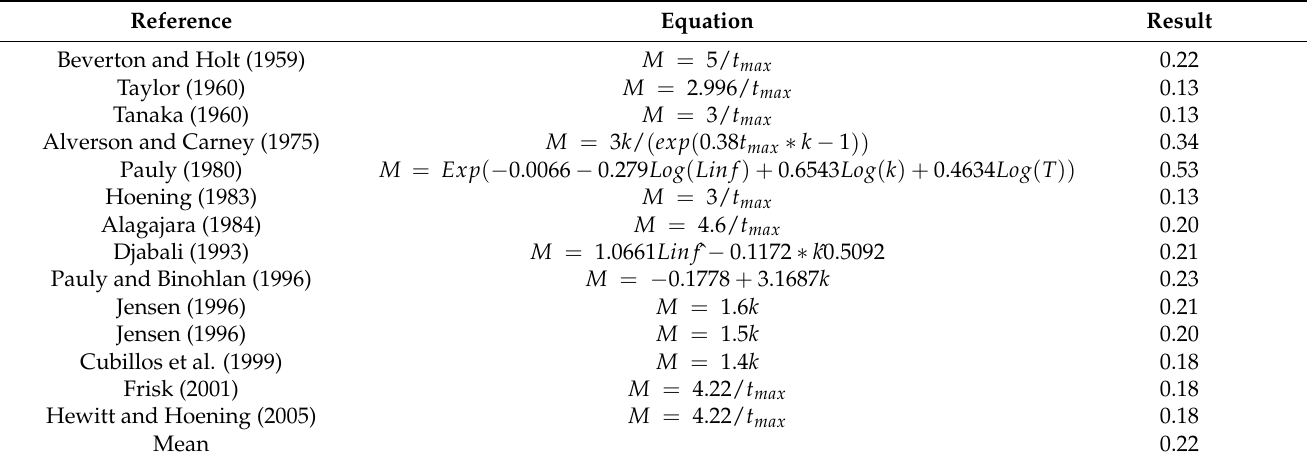
Table 2. Estimates of natural mortality ( M ; year − 1 ) for Lepidopus caudatus in the Azores, estimated from the empirical relationships between the estimated asymptotic length (L ∞ ; cm) and growth rate coefficient (k; year − 1 ).